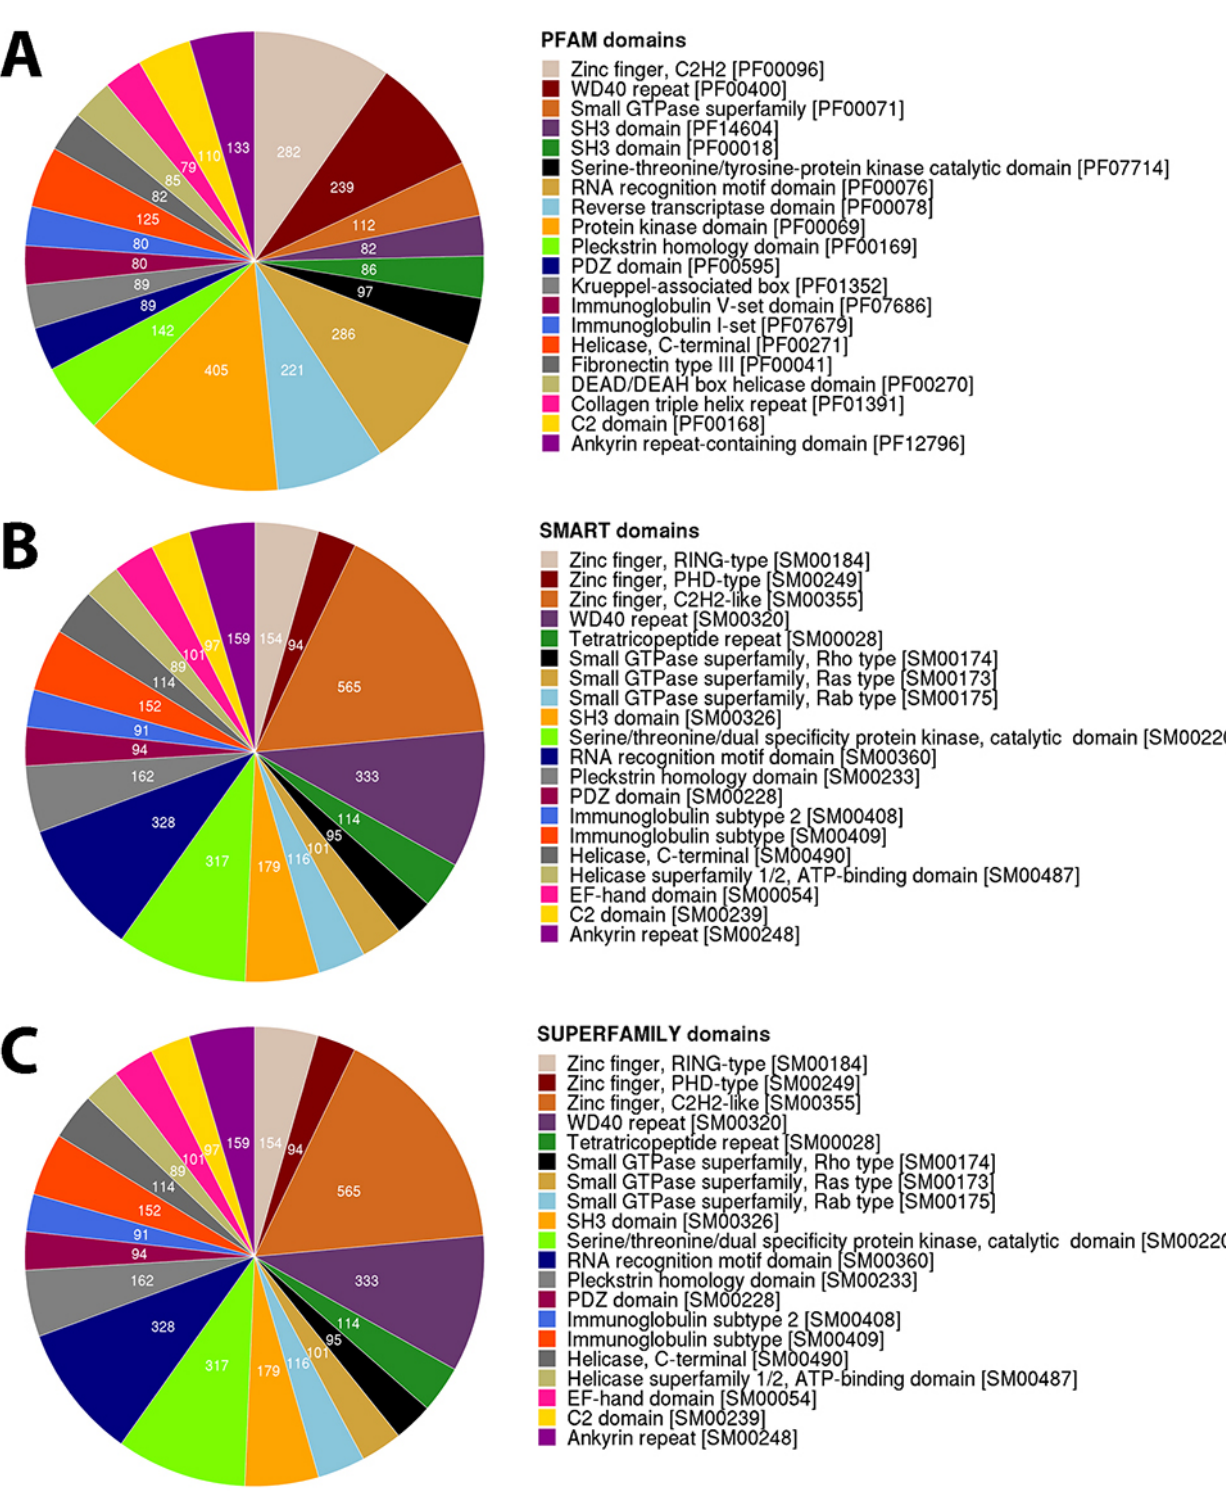
Figure 3. Functional domain annotation of predicted proteins of B. jararaca transcriptome with InterProScan: (A) PFAM, (B) SMART and (C) SUPERFAMILY